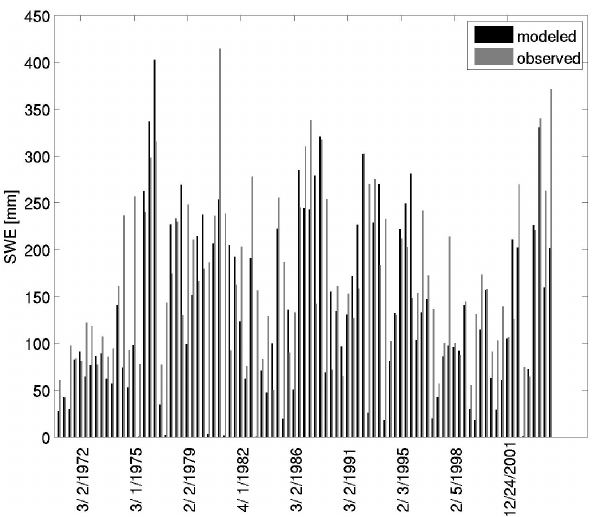
Fig. 4. Comparison of single day SWE observations to modeled quantities at a location in northern part of the E-T basin. The site is located at (38.92 ◦ N and 40.25 ◦ E) and includes once-per-month observations. Sample dates of observed data are provided for refer- ence.